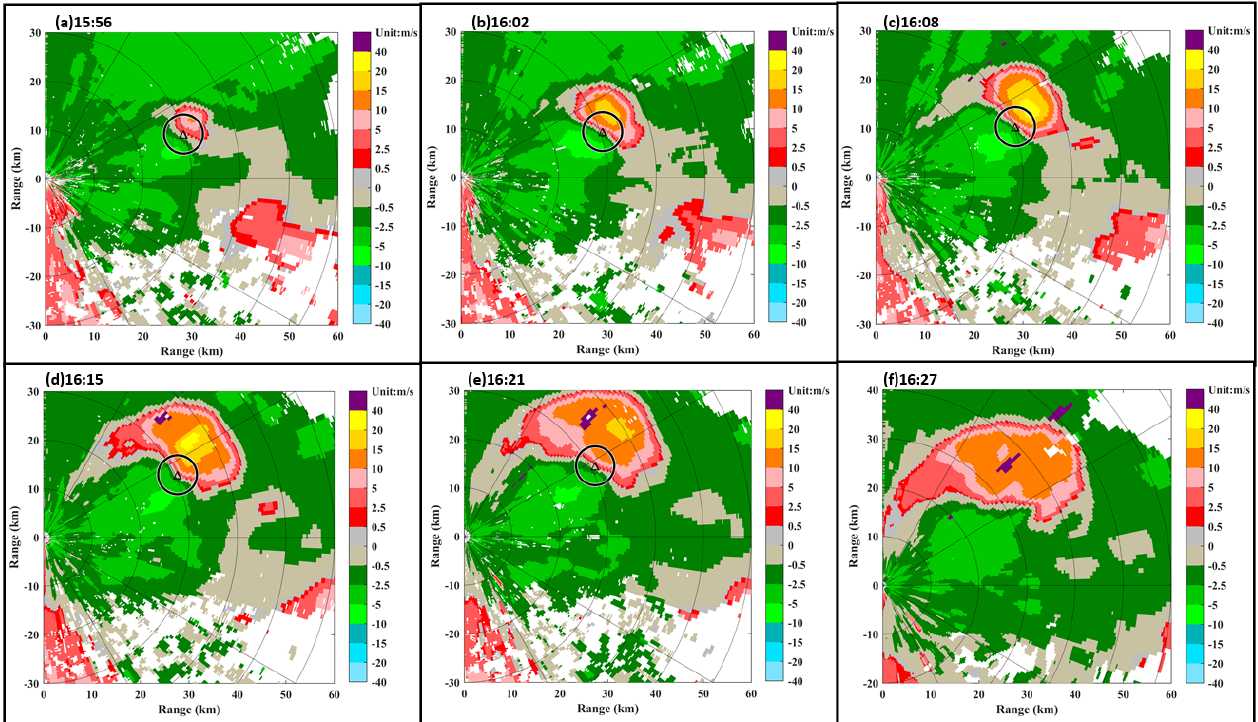
Figure 15 Figure 15. Radar echoes from Jinan, Shandong on 25 July 2006. ( a ) 15:56, ( b ) 16:02, ( c ) 16:08, ( d ) 16:15, ( e ) 16:21, and ( f ) 16:27 is the radial velocity PPI at an elevation of 0.5 ◦ . The black triangle represents the center of the downburst, and black circle represents the range of the